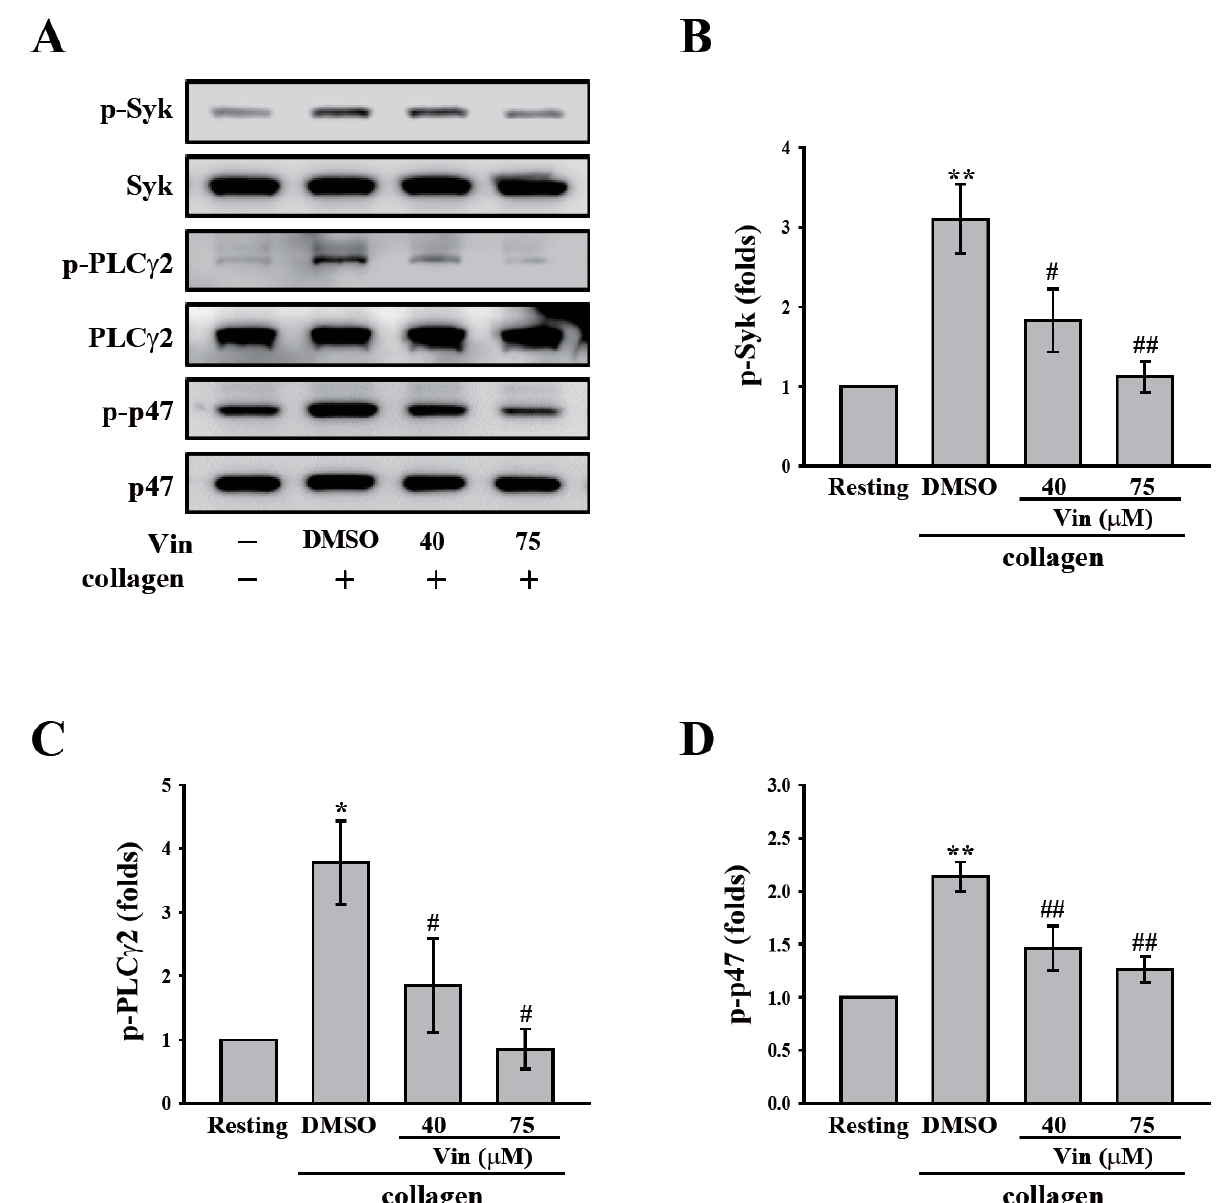
Figure 4. Effects of vincristine on collagen-mediated phosphorylation of Syk, PLC γ 2, and the PKC substrate (p47) in human platelets. ( A – C ) Washed platelets (3.6 × 10 8 cells/mL) were treated with vincristine (40 and 75 µ M) or DMSO before collagen treatment (1 µ g/mL). Protein extracts of platelets were subjected to Western blotting. The total and phosphorylated Syk, PLC γ 2, and p47 were detected using specific antibodies. Profiles in ( A ) are representative examples of three similar experiments. Data in ( B – D ) are presented as the mean ± standard error of the mean ( n = 3). * P < 0.05 and ** P < 0.01 compared with the resting group. # P < 0.05 and ## P < 0.01 compared with the DMSO (solvent control) group.